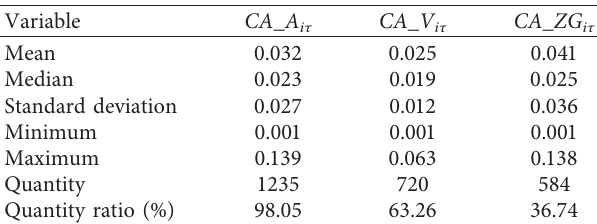
Table 5: Statistics on green enterprise investment efficiency.